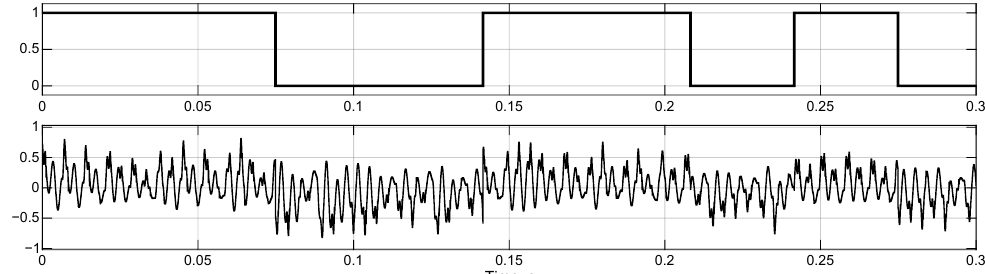
Figure 4. Spreading of the data bits using a continuous chaotic waveform. Transmitted data bits are drawn in the upper graph, switched chaotic waveform-lower graph. Each data bit is spread with approximately 9 oscillations of the chaotic waveform.